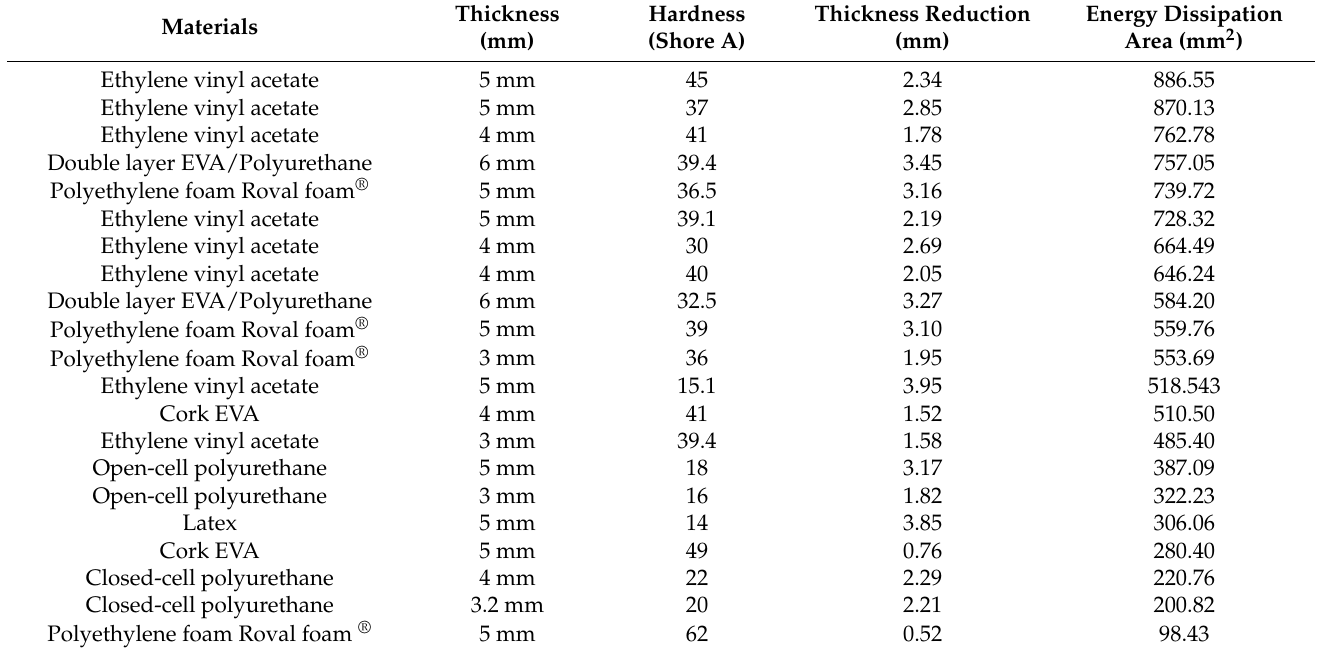
Table 1. Dissipation area of the different materials studied related with their